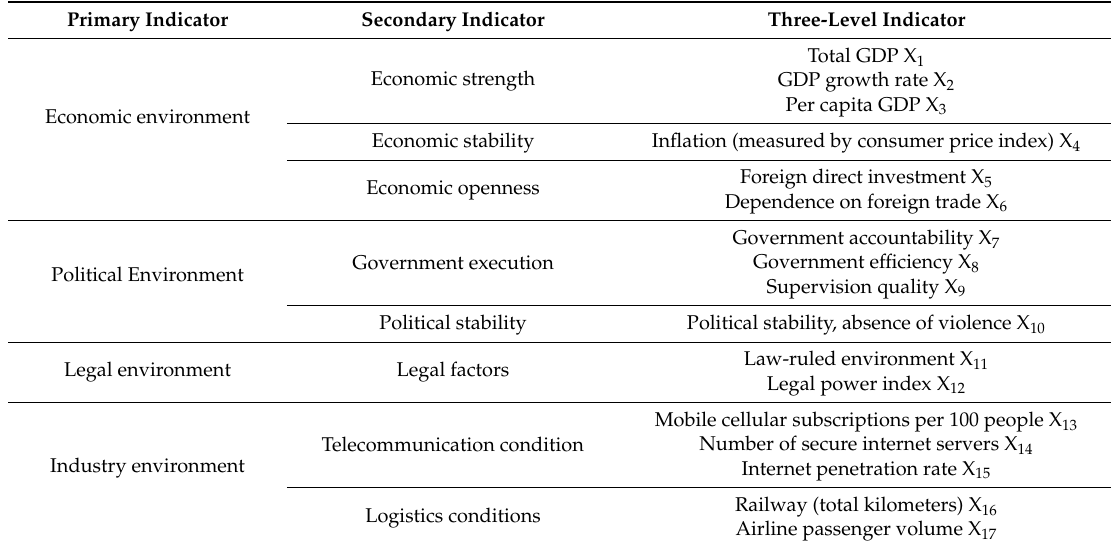
Table 2. Investment environment evaluation index system for cross-border e-commerce investment in seven